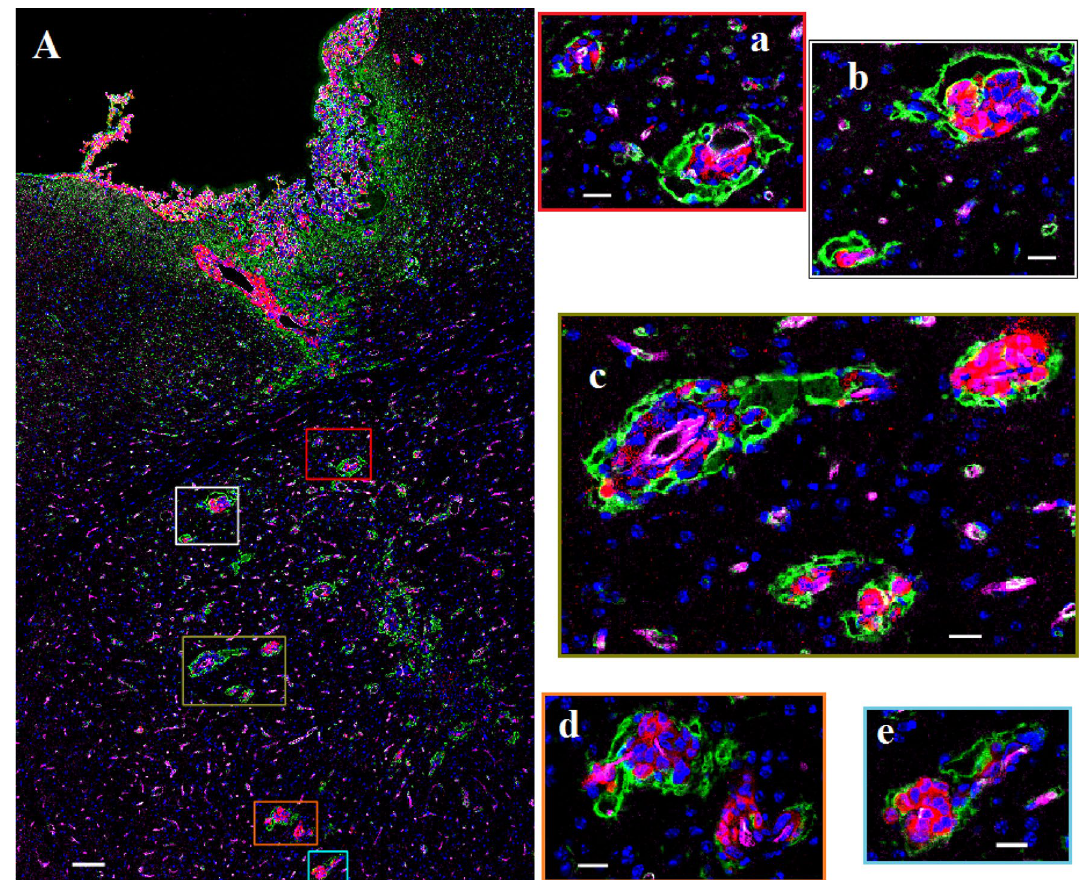
Figure 5. Fluorescence labeled confocal images (20 ×) of left cerebral hemisphere of athymic nude mice bearing MBD-MD-231 tumors 24 h after iv INP administration. A . Main tumor mass with migrated tumor loci deep into the cerebrum with INP uptake seen as a bright ring. White bar = 100 um. a – e : enlarged fluorescent image of the migrated tumor foci; white bar = 20 um. Tumor cells (td-Tomato, red); INPs (anti-PEG, green); Endothelial stain (antiCD31, violet); Nuclei (Dapi-Blue). Images are of all four colors combined. Intense CD31 stain is seen around blood vessels with associated tumor-cells. Green INP staining does not permit the lower intensity antiCD31 stain to show